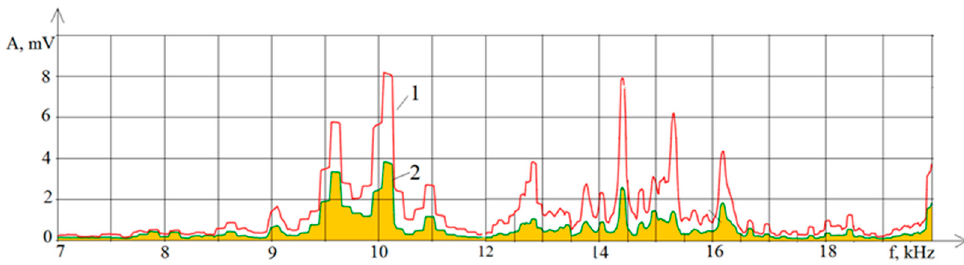
Figure 7. The VA spectra during laser processing with a power output of 60% (1) and 40% (2).